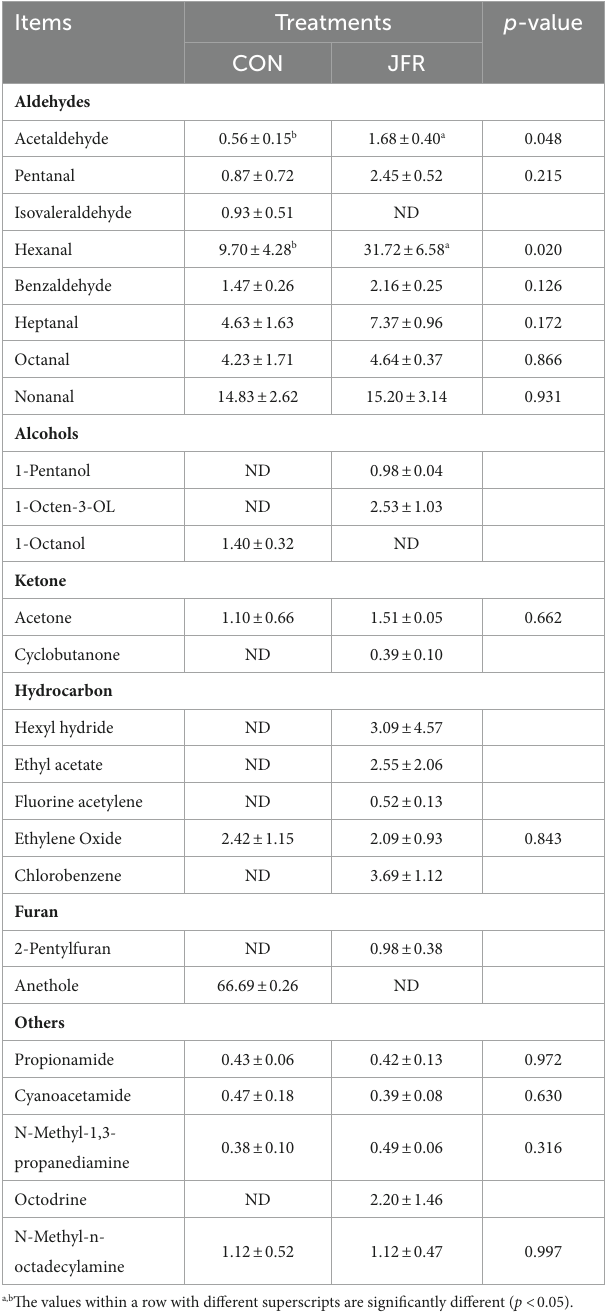
TABLE 5 Effect of dietary jasmine flower residue supplementation on volatile composition.